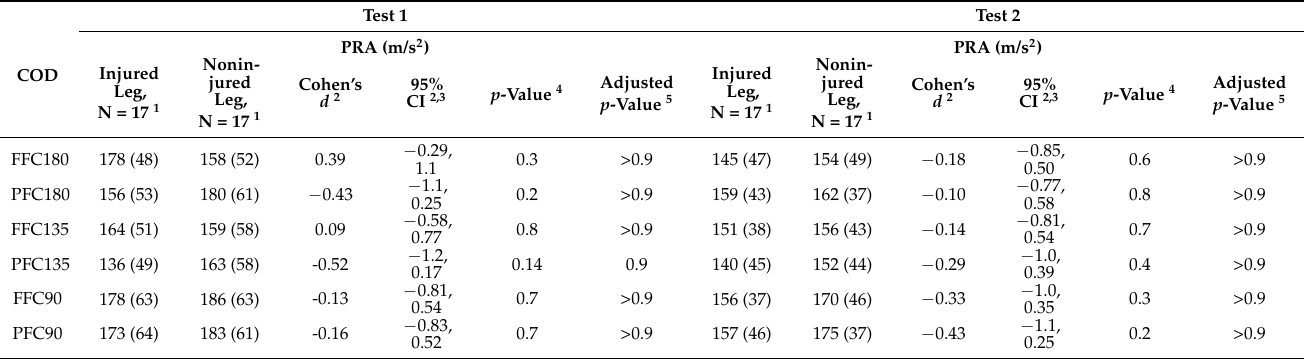
Table 3. Comparison of injured and noninjured leg peak resultant acceleration (m/s 2 ) differences in the previously injured